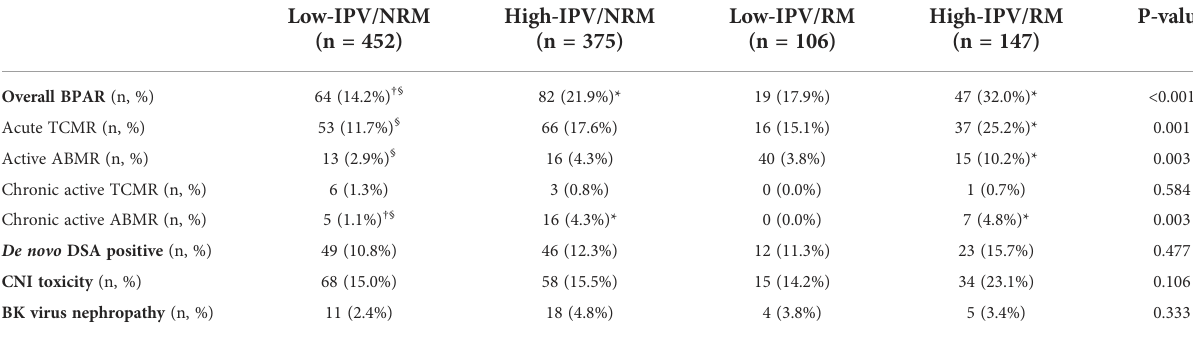
TABLE 2 Incidences of BPAR and other outcomes according to TAC-IPV and RM/NRM